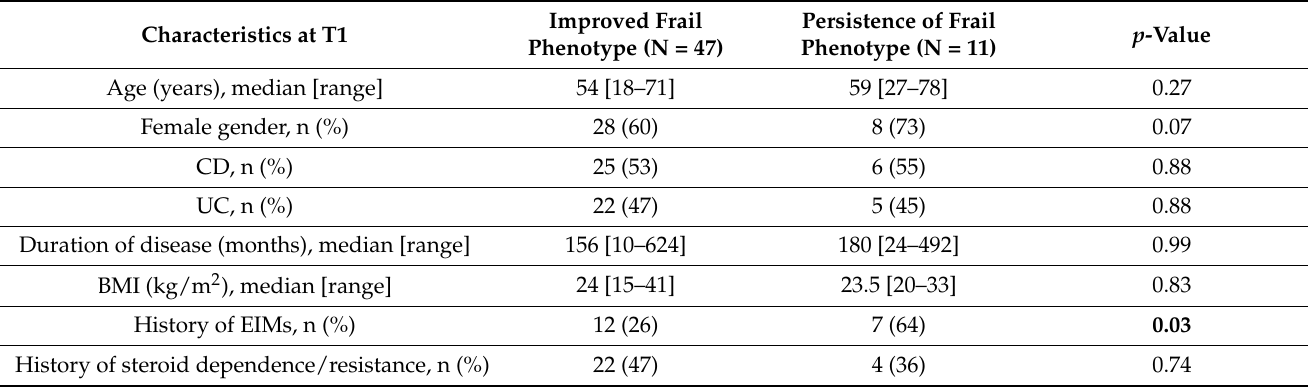
Table 3. Demographic and clinical characteristics of patients with IBD who improved their phenotype at the end of the study (T1) compared to patients with IBD who maintained a frail phenotype at T1. CD: Crohn’s disease; UC: ulcerative colitis; BMI: body mass index; EIMs: extraintestinal manifestations; ISS: